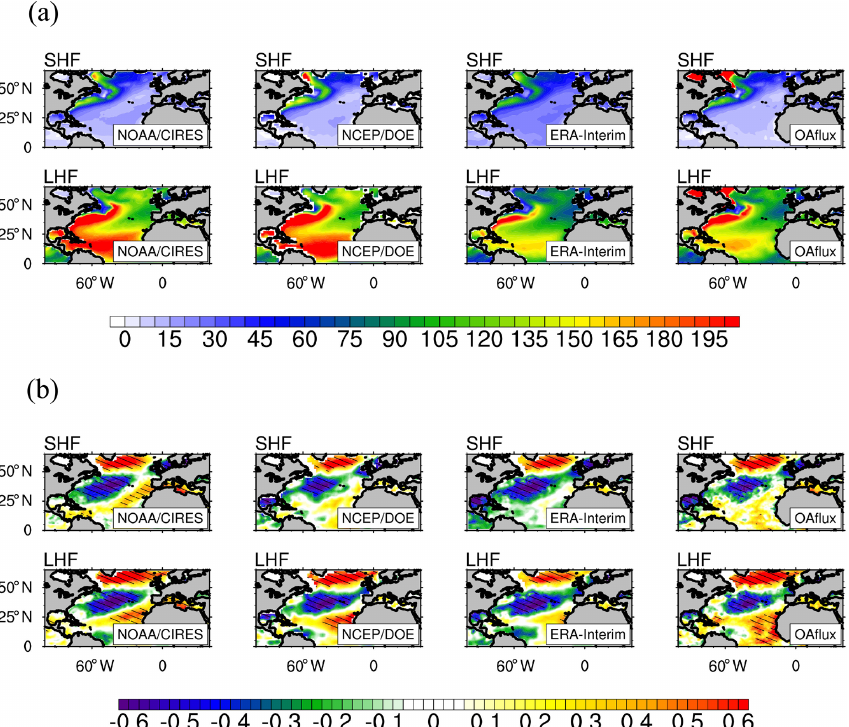
Figure 6. (a) Observed multiyear mean winter sensible (SHF) and latent heat flux (LHF) (Wm − 2 ), and (b) standardized RCs of the winter- average SHF and LHF anomalies against the NAO indices. The time periods of the four datasets used in this figure range from 1980 to 2015. The three observation-based data from the NOAA-CIRES (NOAA-CIRES), NCEP (NCEP-DOE), and ECWMF (ERA-Interim) are reanalysis data, and the last one (OAflux) is the optimal syntheses of voluntary observing ships, reanalysis, and satellite data